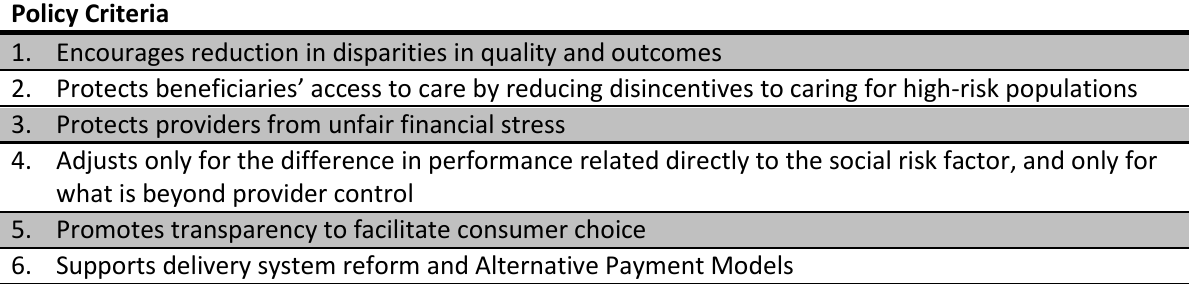
Table 13.10: Policy Criteria Policy